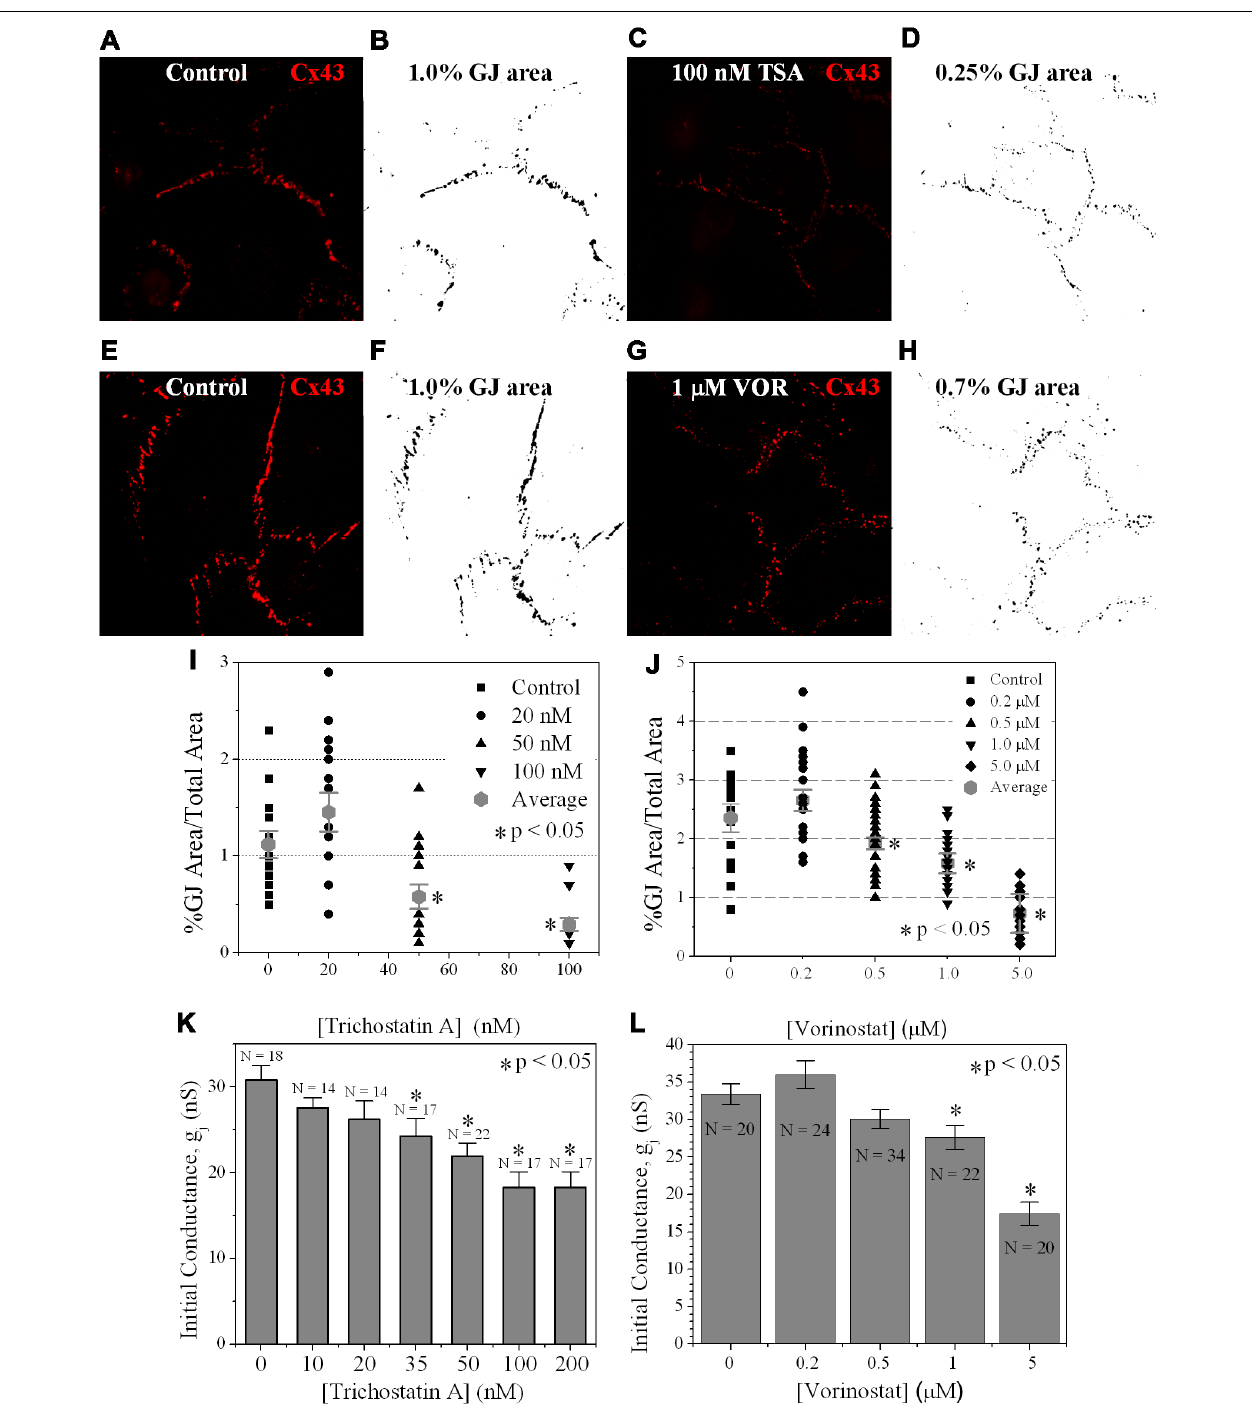
and [VOR]. (I,J) Statistical analysis of the average Cx43 GJ area values ( ± SEM, n = 15) at each pan-HDACI concentration revealed a significant decrease in GJ area for [TSA] ≥ 50 nM and [VOR] ≥ 500 nM. (K,L) Initial gap junction conductance ( g j ) measurements, upon establishment of the dual whole cell patch clamp configuration, from numerous ( n = 14–34) cell pairs revealed a dose-dependent maximum decrease in ventricular g j of 40–50% by pan-HDACI.The decline in ventricular g j was statistically significant for [TSA] ≥ 35 nM and [VOR] ≥ 1 μ